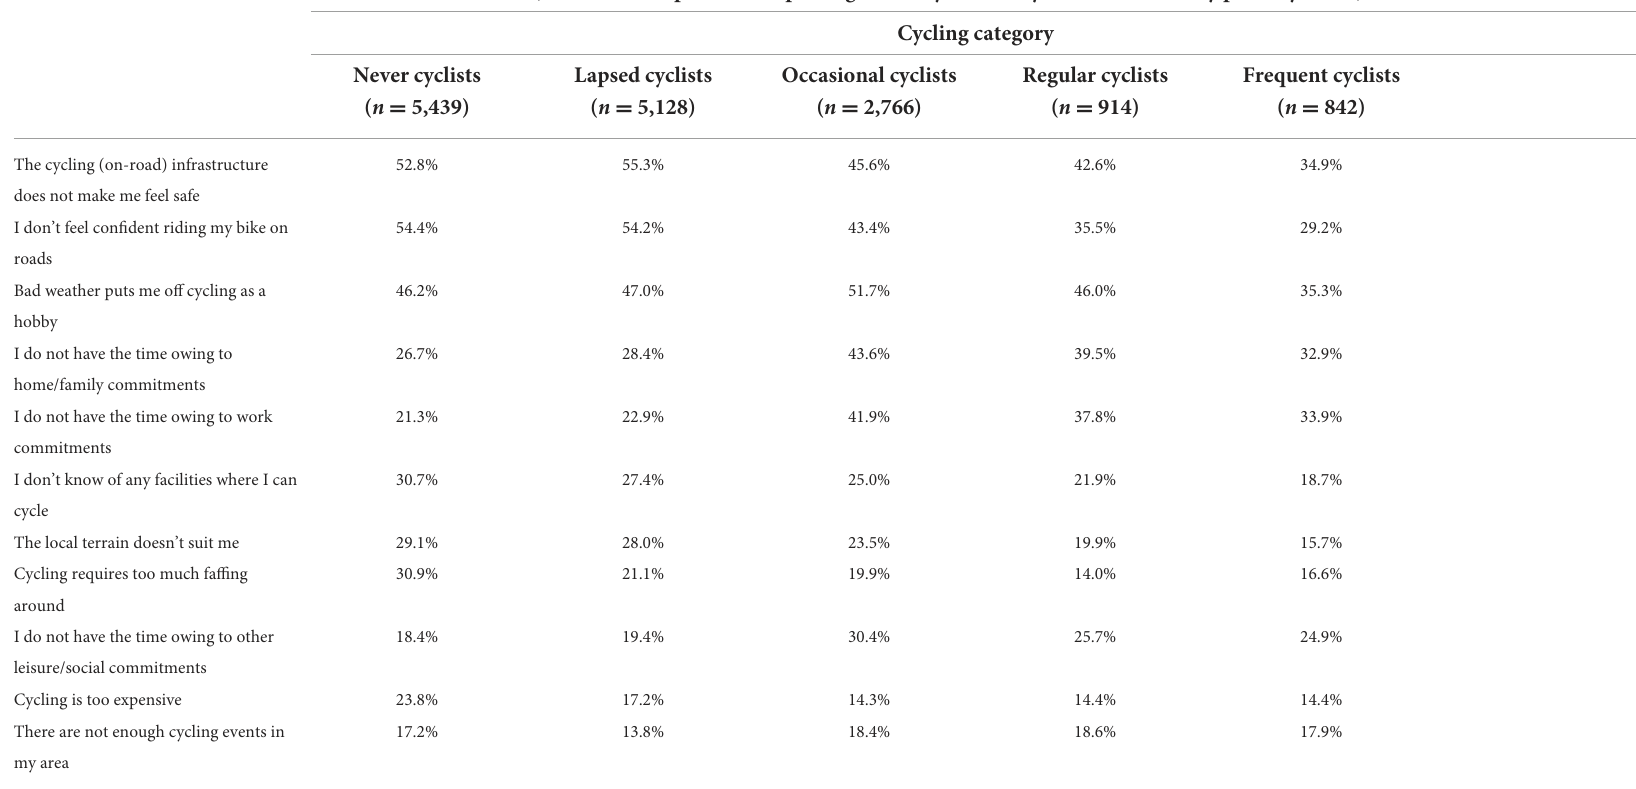
TABLE 2 Responses to questions about barriers to cycling in a nationally-representative UK survey.